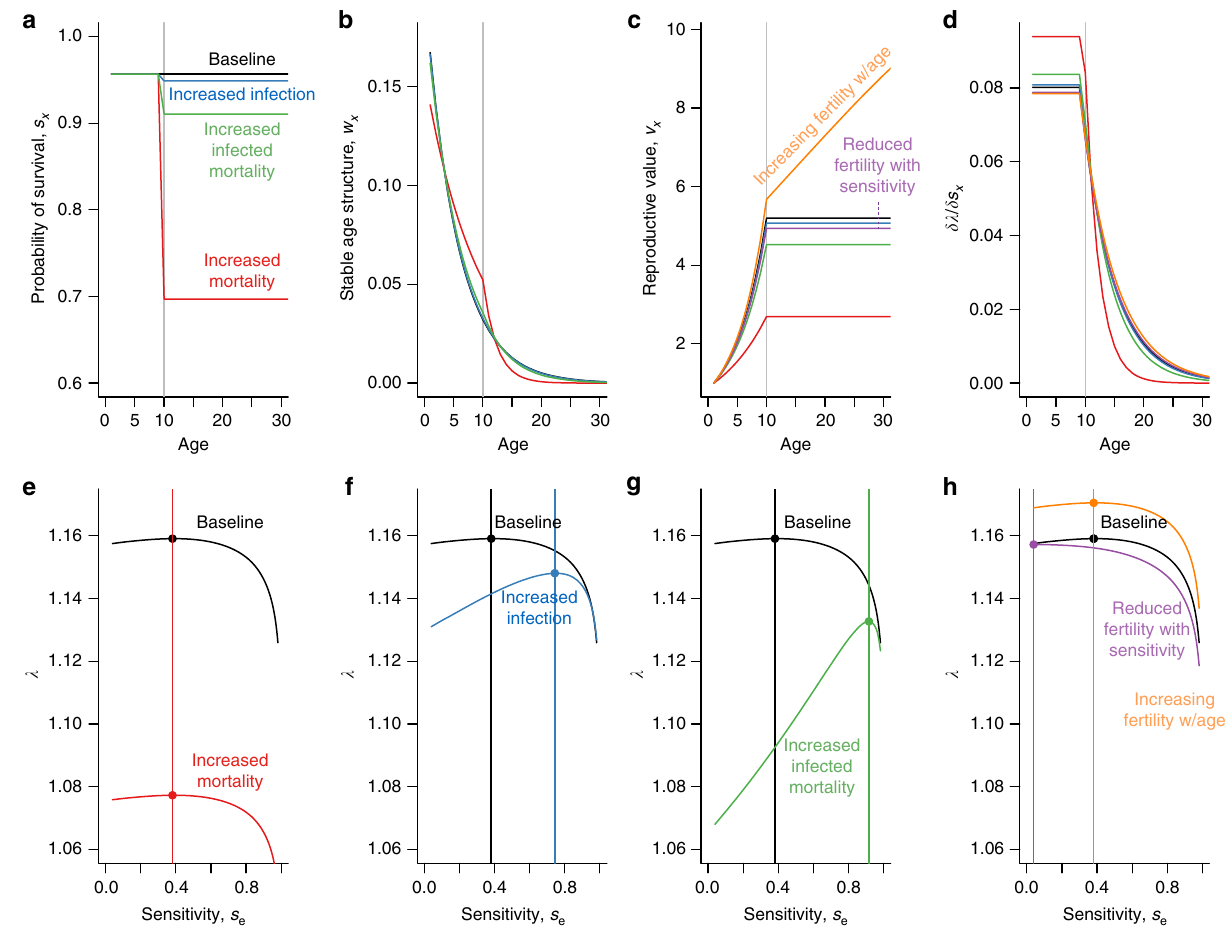
Fig. 3 Tracking the impact of changing sensitivity from survival to fi tness a Survival: across age ( x axis) scenarios include constant survival ( y axis, black), reduced survival associated with increased infection during reproductive years (blue, starting at the age of maturity indicated by the gray vertical line), reduced survival associated with infection during reproductive years, although probability of infection remains constant (green, as before), and overall reduced survival (e.g., associated with risks of birth, or other investments for in reproduction), again with constant probability of infection (red, as before); b Stable population structure: changes in the age pro fi le of survival directly alter the stable population structure (colors as before); high mortality during reproductive years reduces the fraction of later aged individuals (all lines are predominantly below the black line for ages above the age of maturity) and if suf fi ciently large, can increase the fraction of younger aged individuals across some ages (red line is above the other lines). c Reproductive value: reducing survival reduces the reproductive value of individuals, colors as before with two additional scenarios added for comparison: increased fertility with age (orange), and reduced fertility for higher levels of sensitivity (purple). d Effect of changes of survival on fi tness as measured by the populations rate of increase, λ , is the product of the stable population structure ( b ) and reproductive value ( c ); largest impacts are found for increasing survival at young ages for the scenario with the lowest overall survival. The overall optimal strategy for sensitivity ( e ) does not change with baseline mortality (colors as above, see Methods) as long as infection is constant over age (but see Fig. 4), increases with infection during reproductive years ( f ), or mortality associated with infection during reproductive years ( g , h ) is reduced by a reduction of fertility by sensitivity (e.g., if miscarriage is a risk during pregnancy) and unaffected by a change of fertility with age (but see Fig.